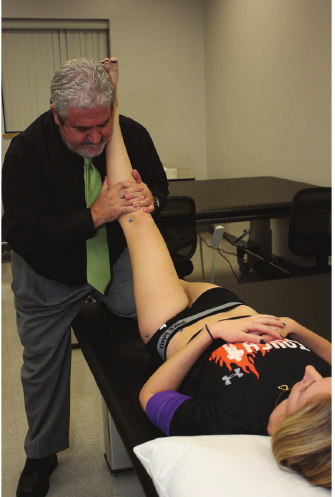
Figure 3: Static stretching of the hamstring muscles was performed for 30 seconds, 6 times on their dominant leg for a total stretching time of 180